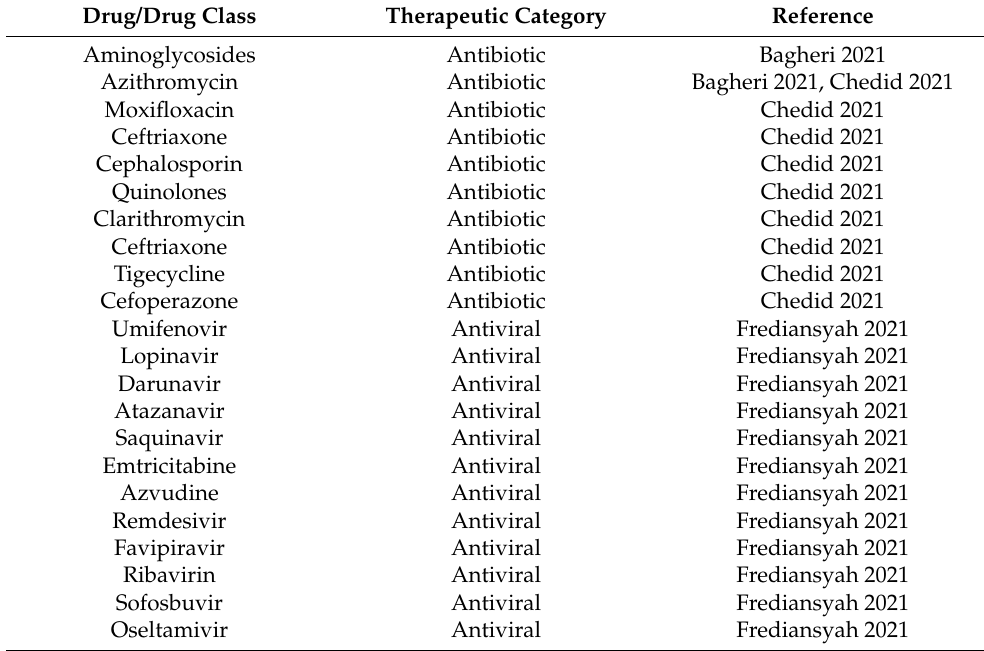
Table 1. Some antiviral and antibiotics that are used in COVID-19 treatment, as reported by Chedid 2021 [51], Bagheri 2021 [52], and Frediansyah 2021